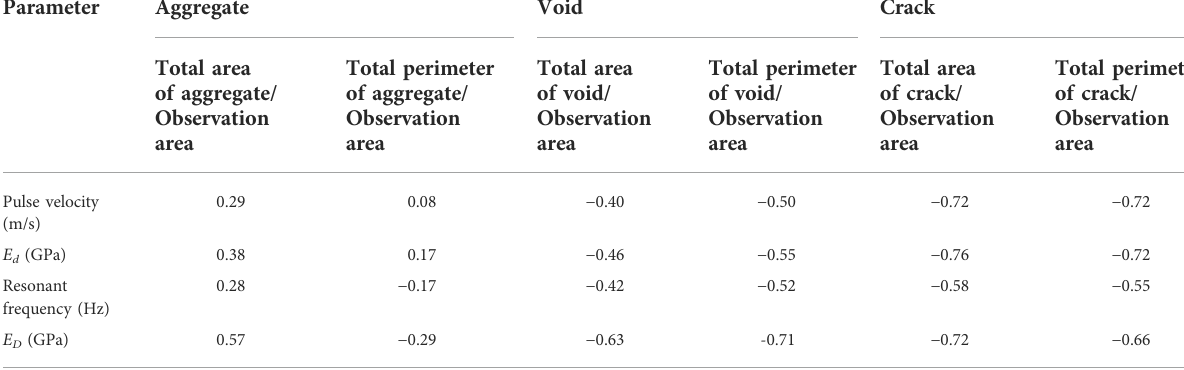
TABLE 6 Correlation between NDT parameters and proportions parameters of concrete components.